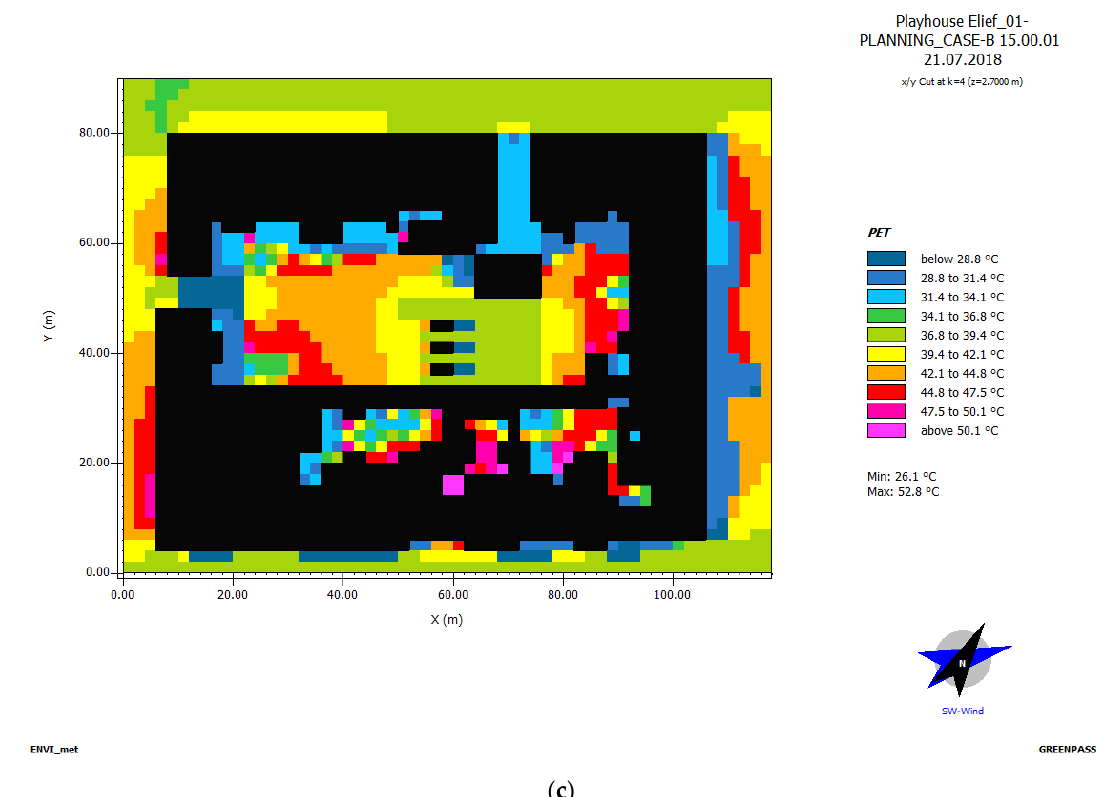
Figure 8. Results of microclimatic simulation Playhouse Elief Antwerp, comparison on a hot summer day 21.7: ( a ) Variant SQ—PET 15:00 at roof level; ( b ) Variant A—PET 15:00 at roof level; ( c ) Variant B—PET 15:00 at roof level.